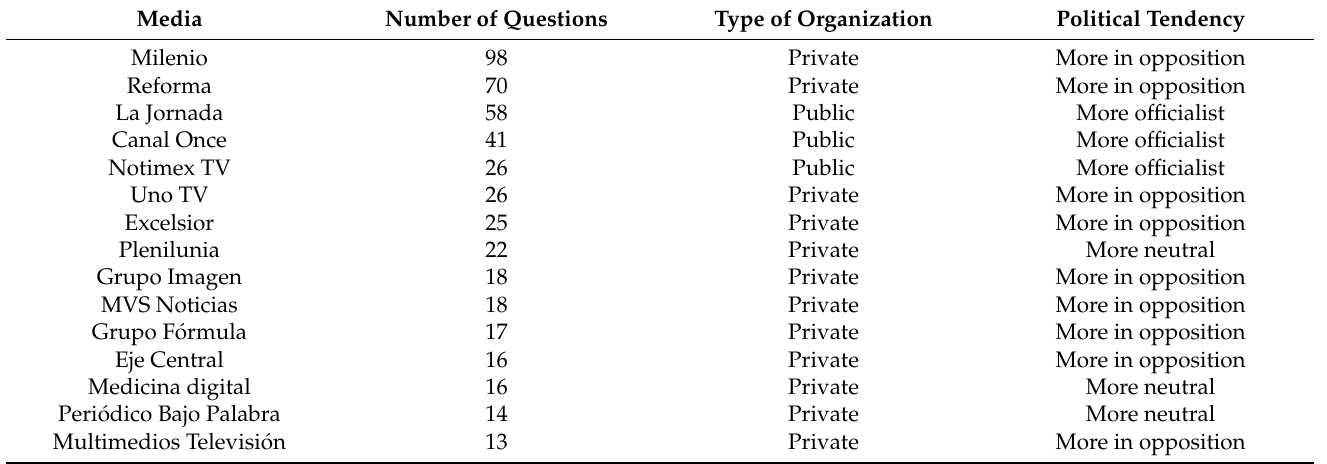
Table 1. Type of organization and the political tendency of the 15 participating media